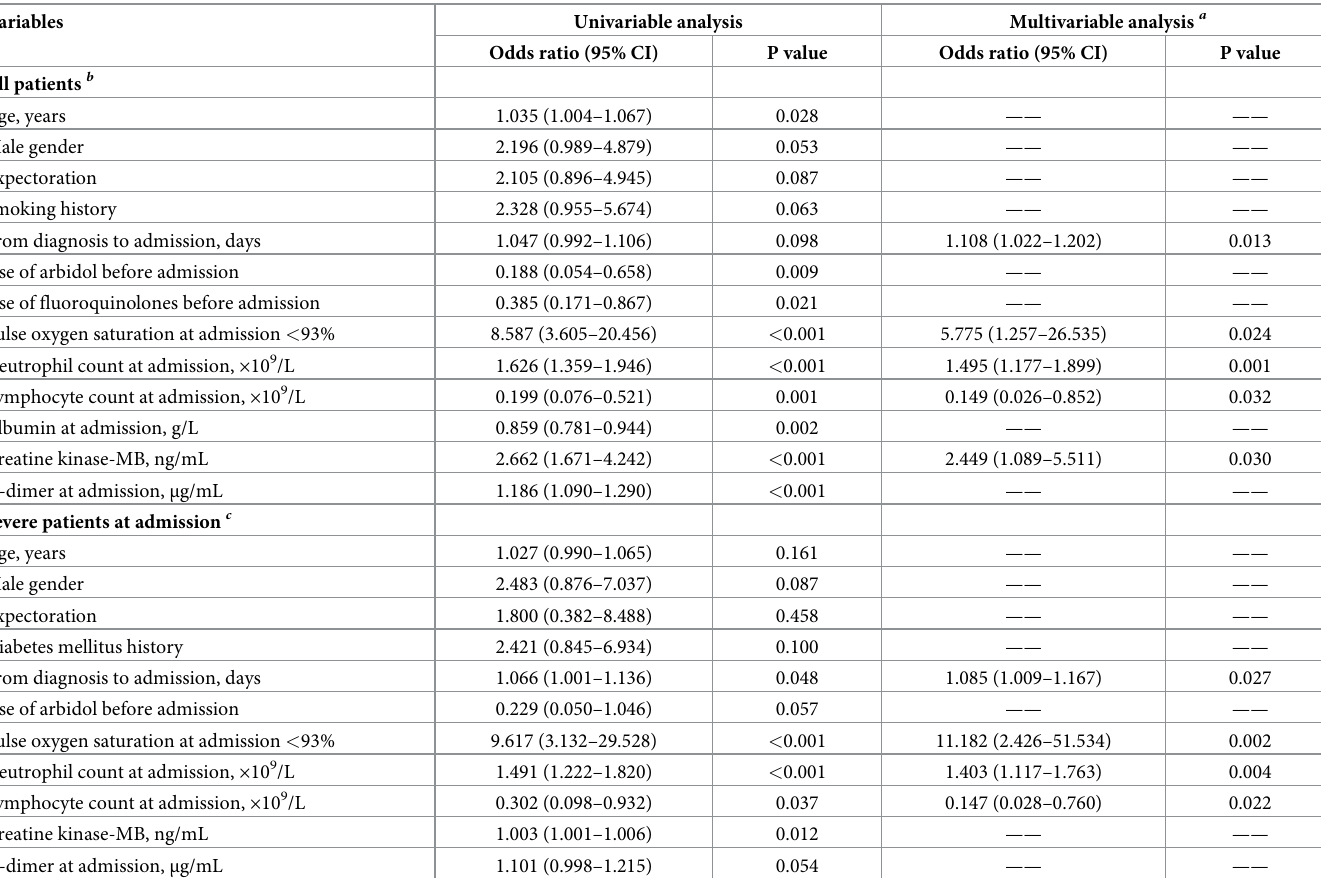
Table 4. Predictors of progression to critically ill